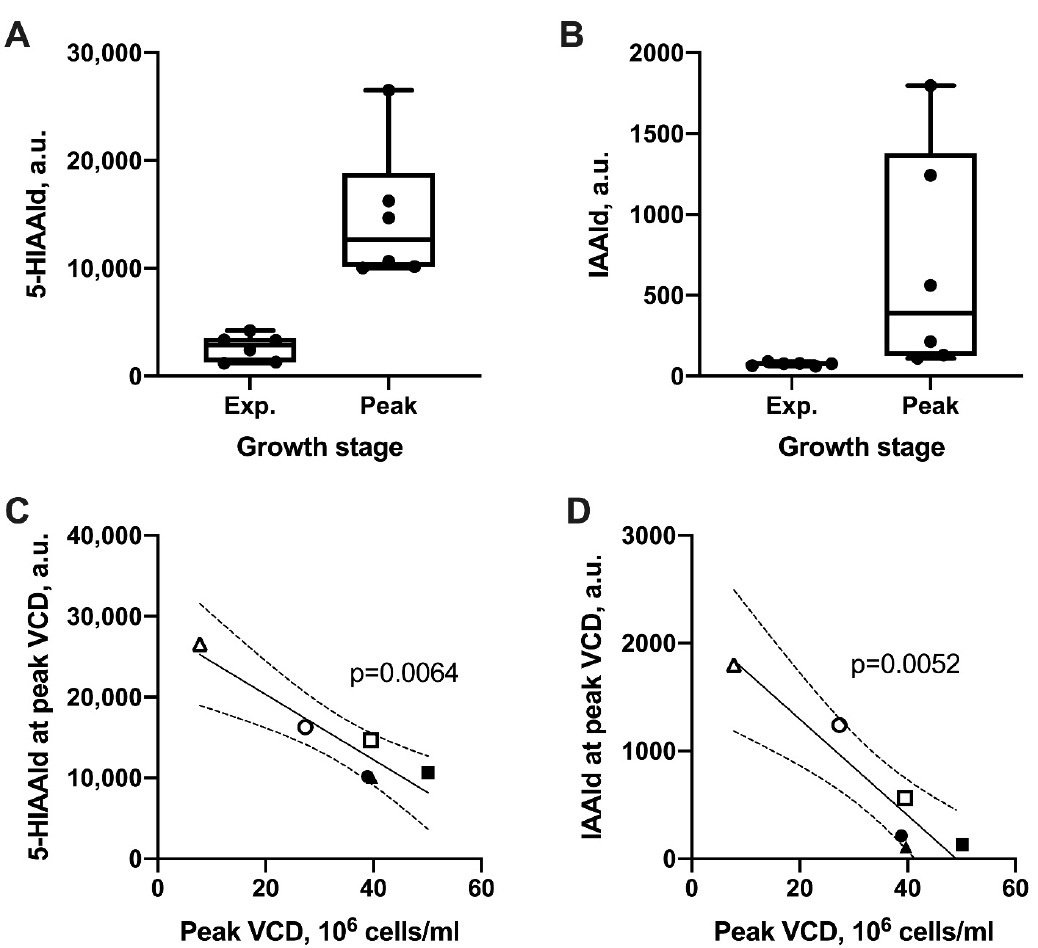
Figure 3. Tryptophan metabolites negatively correlating with cell growth. Medium concentrations of LC–MS features putatively identified as ( A ) 5-hydroxyindoleacetaldehyde (5-HIAAld) and ( B ) indole 3-acetaldehyde (IAAld) during the exponential growth phase and the stationary phase in the bioreactor cultures. Box plots show the maximum, minimum, and median responses of the LC–MS features (areas-under-the-curve in extracted ion chromatograms) across the six cell lines. ( C , D ) Scatter plots showing regression lines and 95% confidence bands for ( C ) 5-HIAAld and ( D ) IAAld levels in the culture medium at peak VCDs of the six cell lines. Cell lines from host 1 (CHO K1 GS knockout) and host 2 (DG44) are indicated by closed and open symbols, respectively. A p -value < 0.05 indicates that the regression line slope is significantly different than zero by F-test.